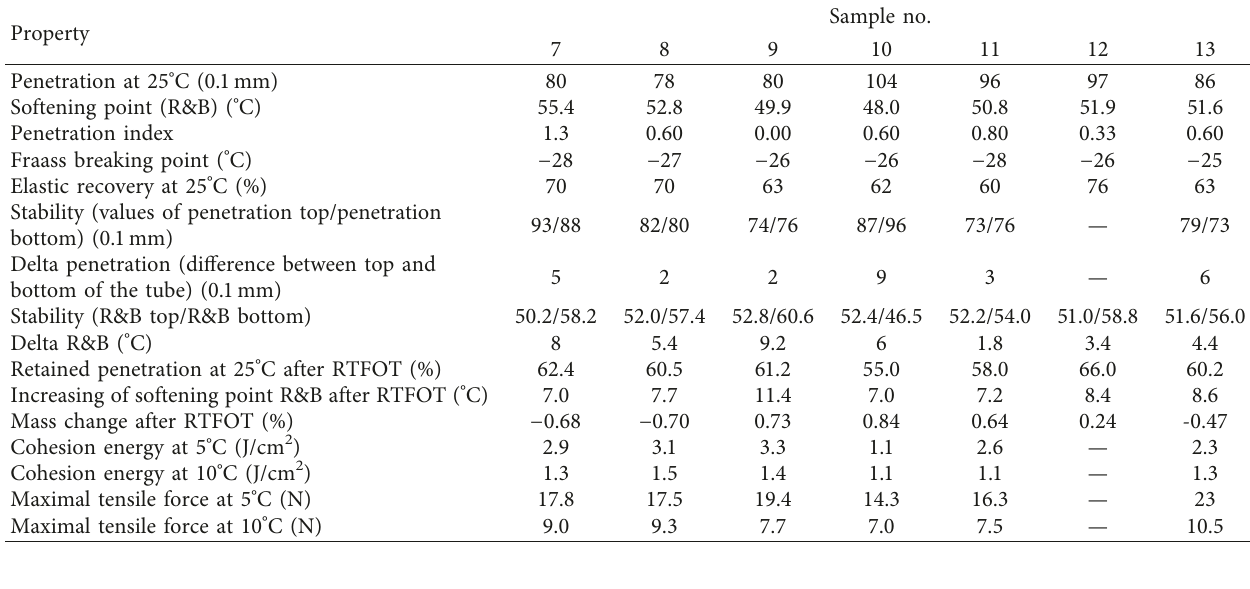
Table 4: Properties of bitumen modified at 220 °